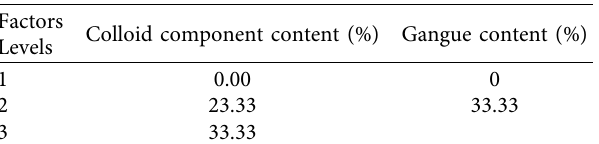
Table 3: Factors and levels of orthogonal